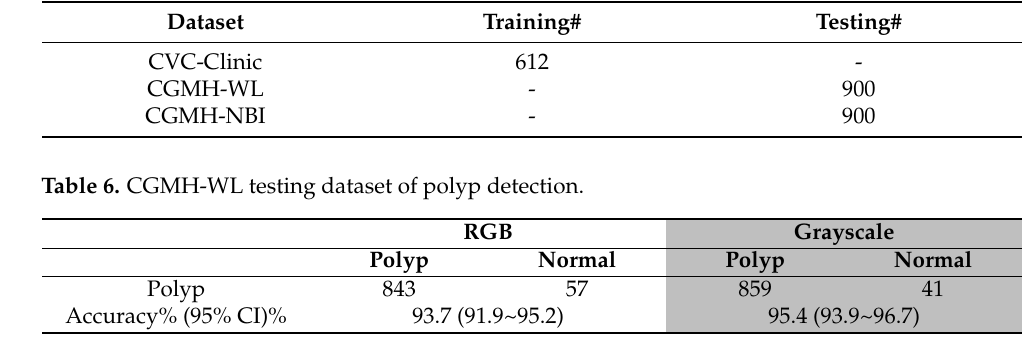
Table 5. Training and testing dataset of polyp detection.